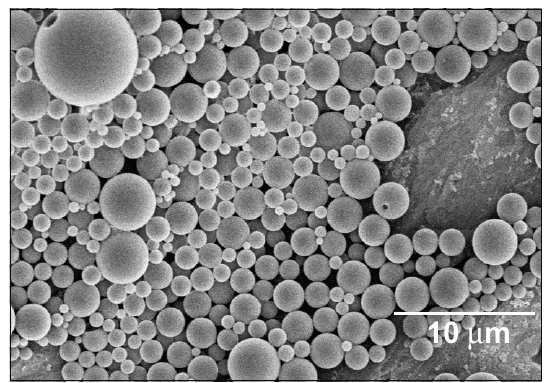
Figure 1. SEM image of a PLA/MMT hybrid latex. Table 1. Thermal properties of polylactides (PLA)/montmorillonite (MMT) latexes after 1 and 8 weeks of aging.